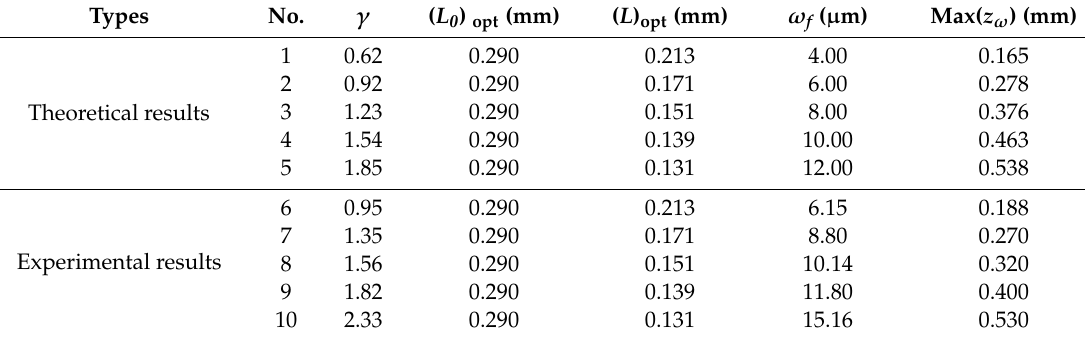
Table 1. Parameters of the GRIN fiber probe with a specified waist